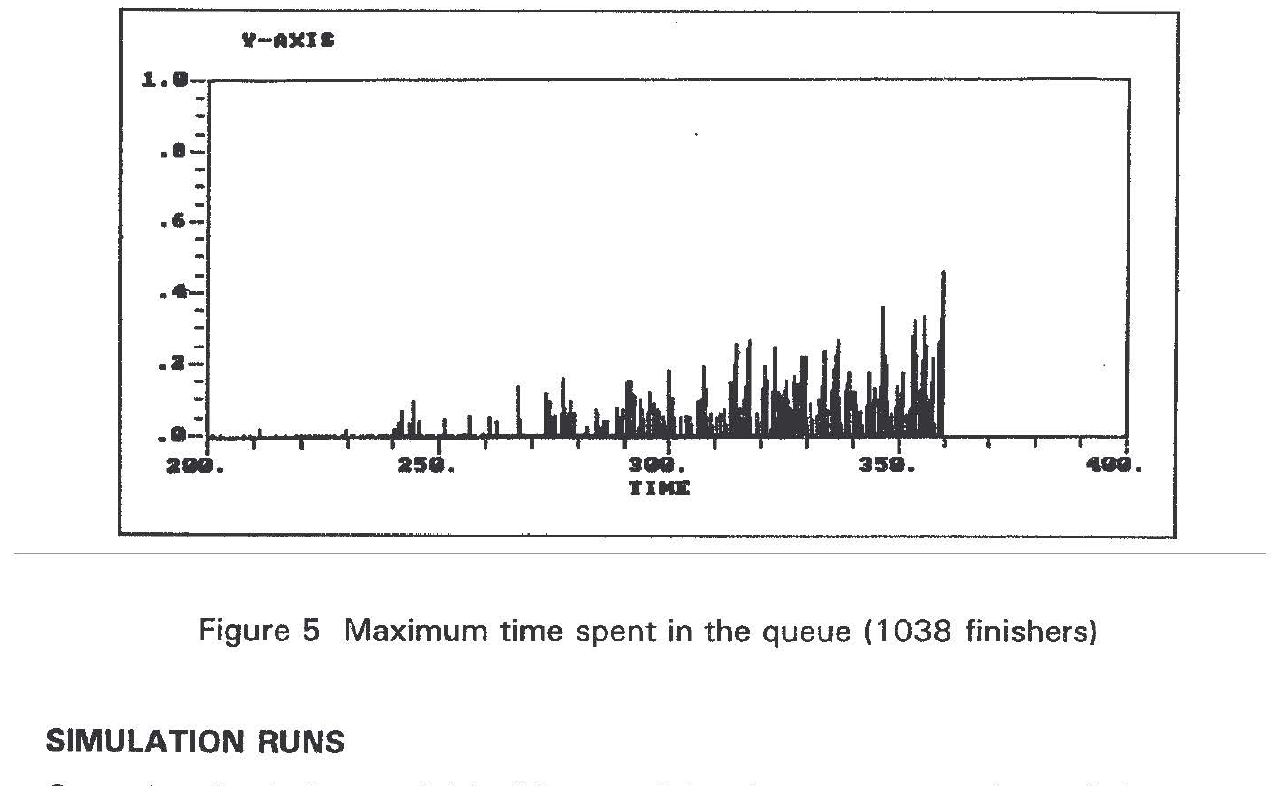
Figure 5 Maximum time spent in the queue ( 1 038 finishers)